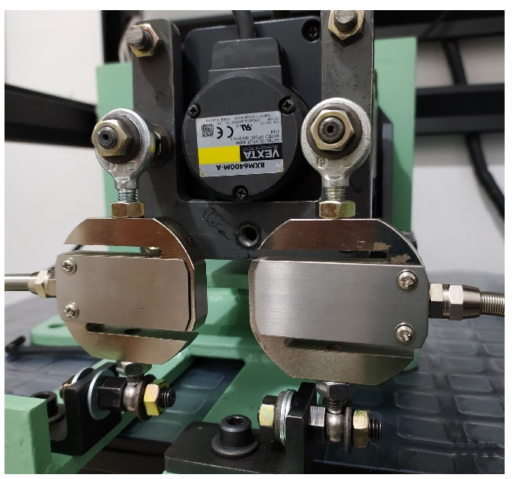
Figure 9. Mounting of load